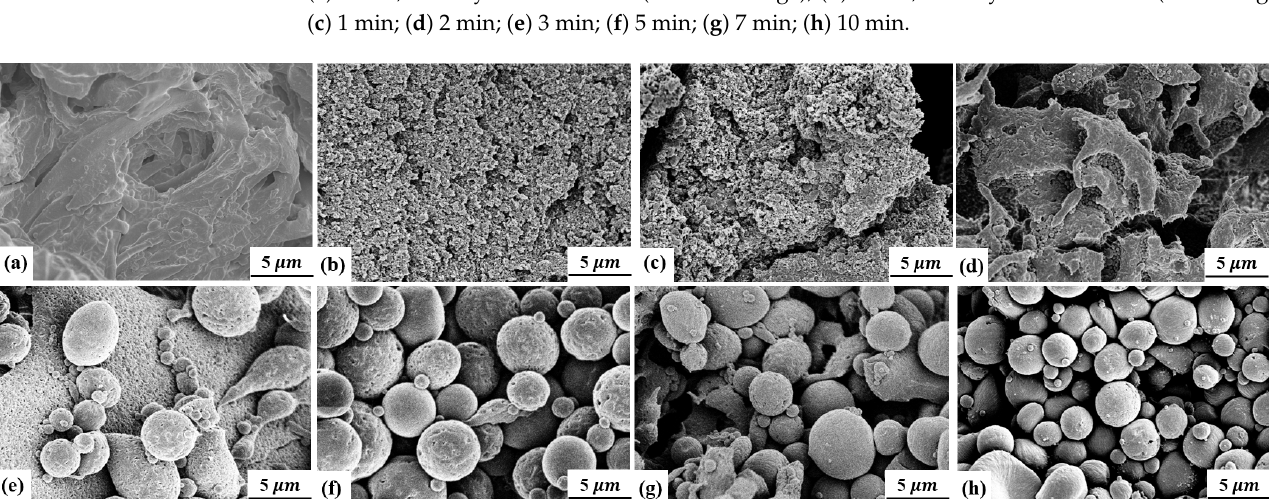
Figure 2. Phase evolution of LC4/LA(30/70) after being statically molten for various durations: ( a ) 0 min, directly out of the TSE; ( b ) 1 min; ( c ) 2 min; ( d ) 3 min; ( e ) 5 min; ( f ) 7 min; ( g ) 10 min; ( h ) 20 min.